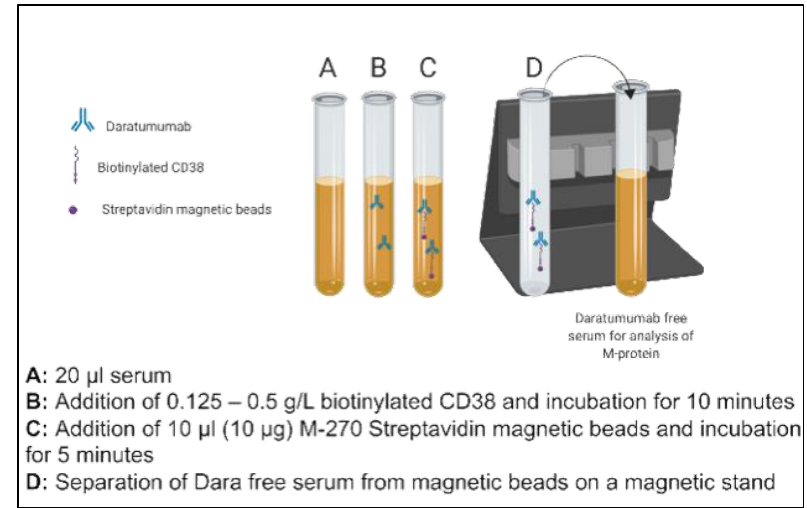
Figure 1. Schematic illustration of steps of a novel immunoaffinity method to deplete residual daratumumab (DARA) using biotinylated recombinant full length CD38 .